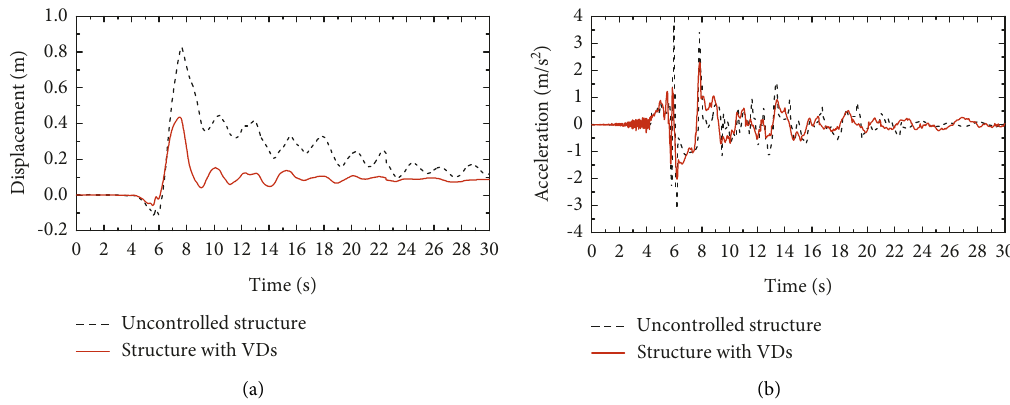
Figure 14: Time history responses at the fourth storey of the steel frame with and without VDs under the pulse-type excitation of record n180: (a) displacement time history and (b) acceleration time history.